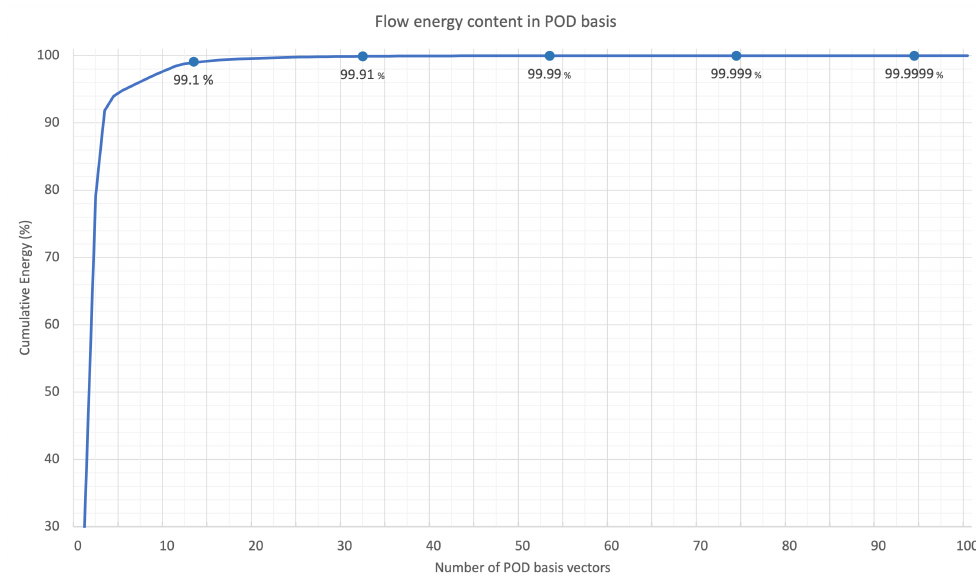
Figure 7. Cumulative energies of the obtained POD base vectors. The first 95 POD bases vectors have a cumulative energy above 99.9%, which means that the rest of the base vectors can be dismissed while still maintaining a high